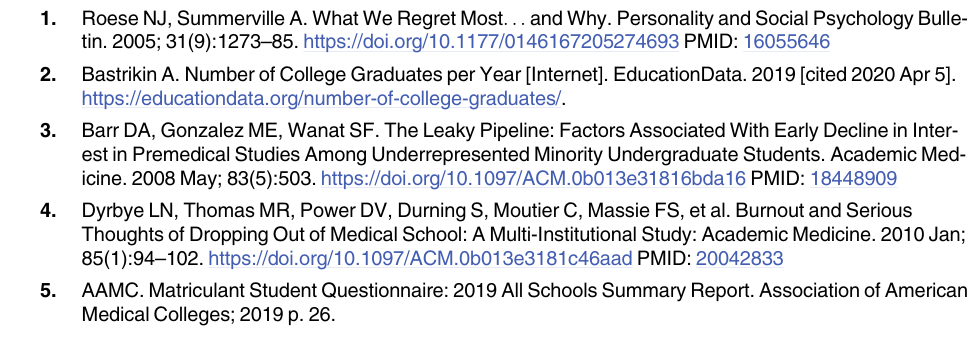
S1 Table. Variable intercorrelations using sub-sample included in the logistic regression model for Milestone 1. S2 Table. Variable intercorrelations using sub-sample included in the logistic regression model for Milestone 2. S3 Table. Variable intercorrelations using sub-sample included in the logistic regression model for Milestone 3. S4 Table. Variable intercorrelations using sub-sample included in the logistic regression model for Milestone